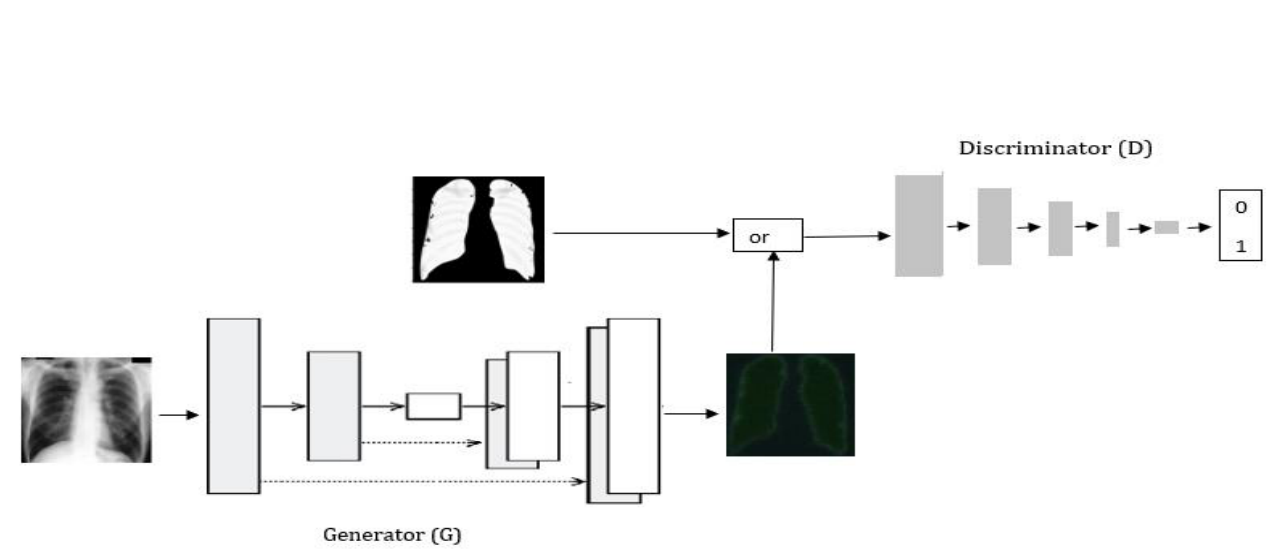
FIGURE 1 GAN ARCHITECTURE. G THE STRUCTURE OF THE GENERATOR IS A U-NET NETWORK THAT WE GIVE THE X-RAY IMAGES AND ITS MASK. D DISCRIMINATION NETWORK, A SIMPLE CONVOLUTIONAL NEURAL NETWORK THAT INPUTS THE GROUND TRUTH IMAGE IS CLASSIFIED WITH THE IMAGE GENERATED BY THE GENERATOR INTO BINARY, IE, "0" OR "1".